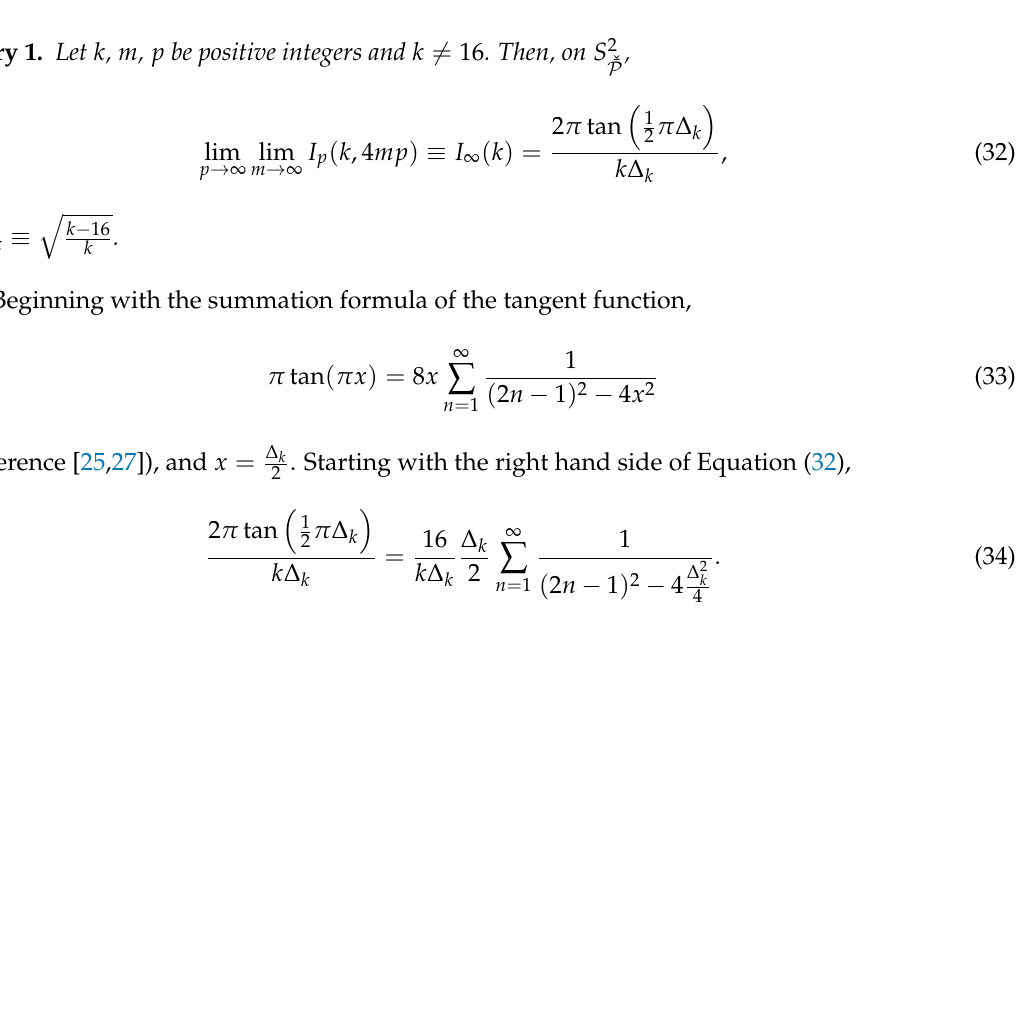
Figure 9. I 1 versus k (dots: | I 1 | - black, Re [ I 1 ] - blue, Im [ I 1 ] - red). The curves arise from Equation (30) in Corollary